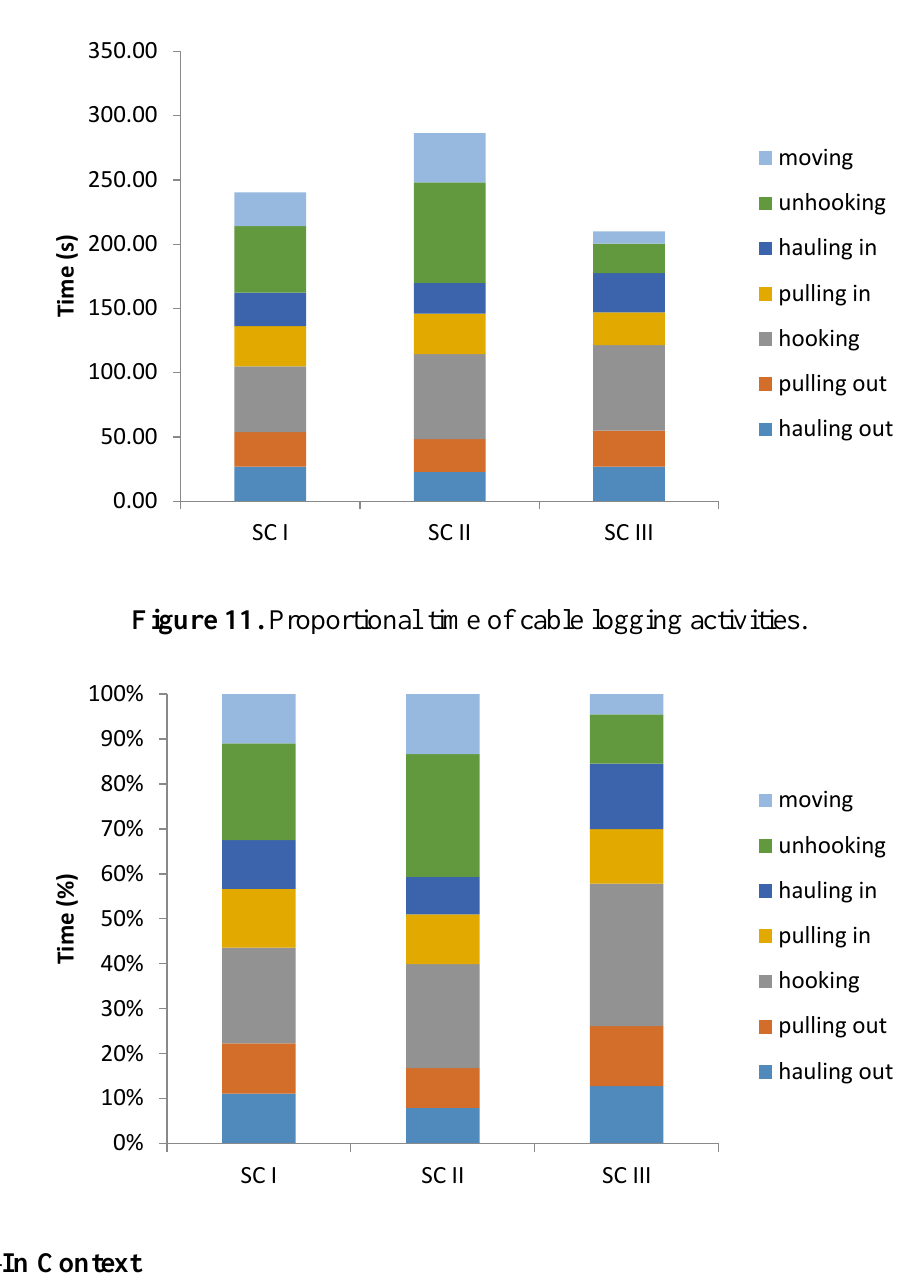
Figure 10. Cumulative time of cable logging activities per cycle.